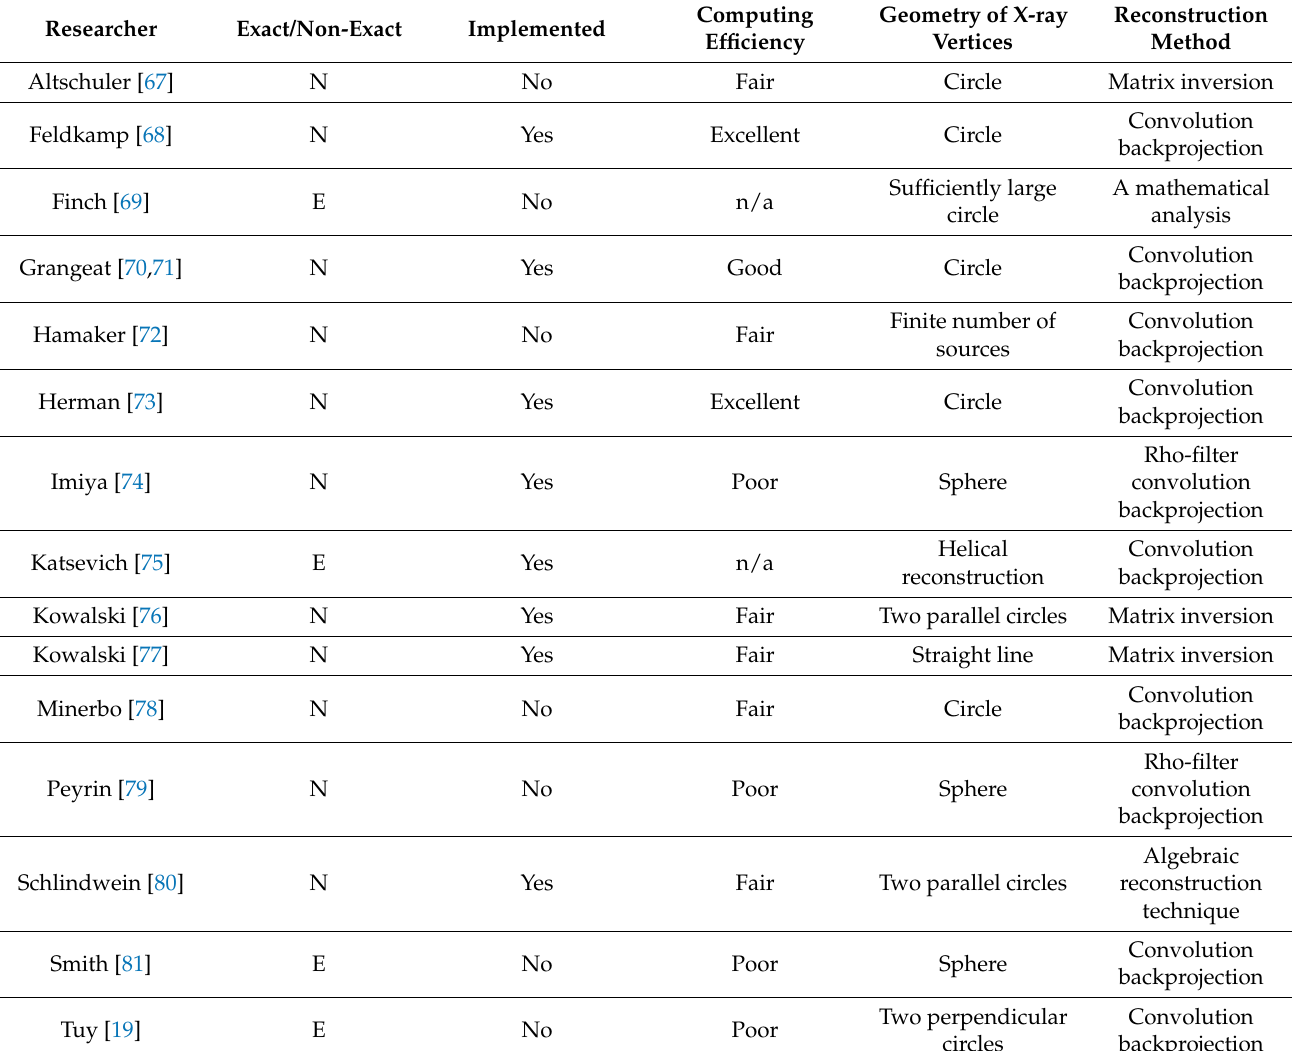
Table 2. Computed tomography reconstruction algorithms